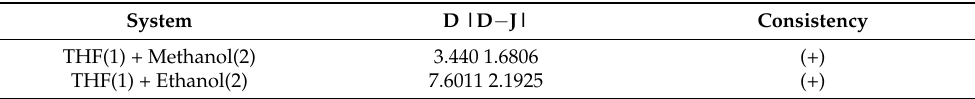
Table 5. The results of thermodynamic consistency when using the Herington test for the isobaric sys- tem.